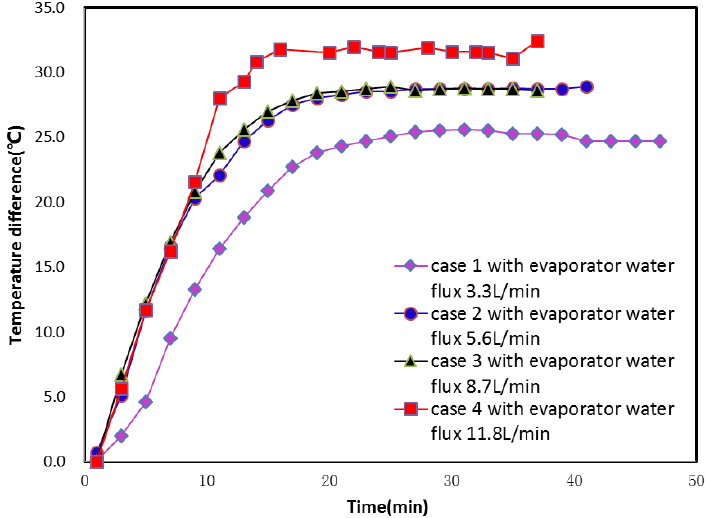
Figure 7. Condenser inlet and outlet temperature differences of the refrigerant at different evaporator water fluxes.